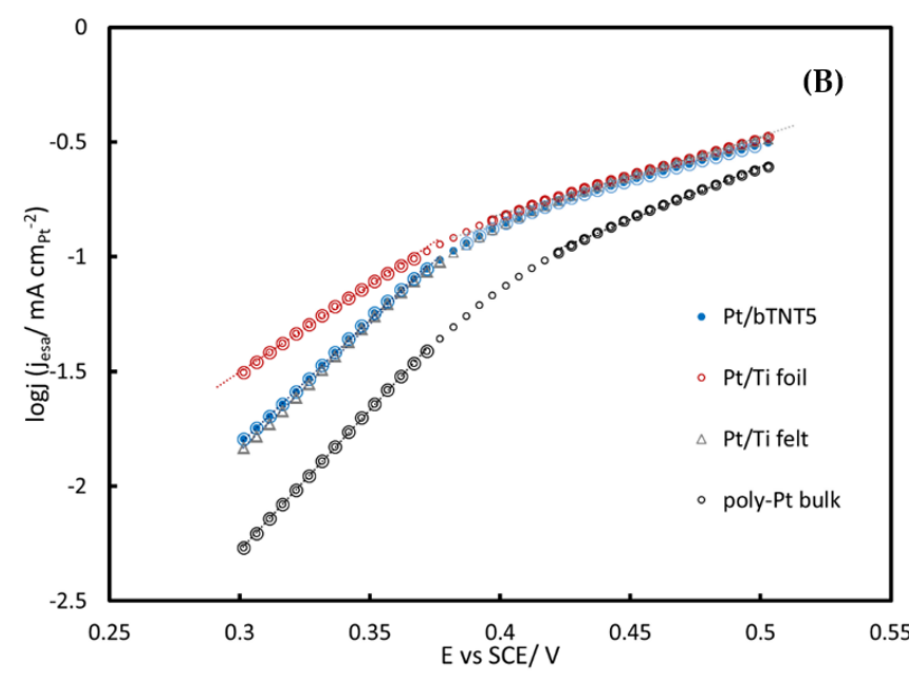
Figure 6. ( A ) Voltammograms of Pt/bTNT5, Pt/Ti foil, Pt/Ti felt and polycrystalline bulk Pt in a N 2 -deaerated solution of 0.1 M HClO 4 + 0.5 M MeOH, at a low scan rate of 5 mV s − 1 , scanned between +0.1–+0.8 V SCE (forward scans) and ( B ) . Tafel slopes of logj vs. E. The current is normalized per Pt electroactive area in cm 2 .